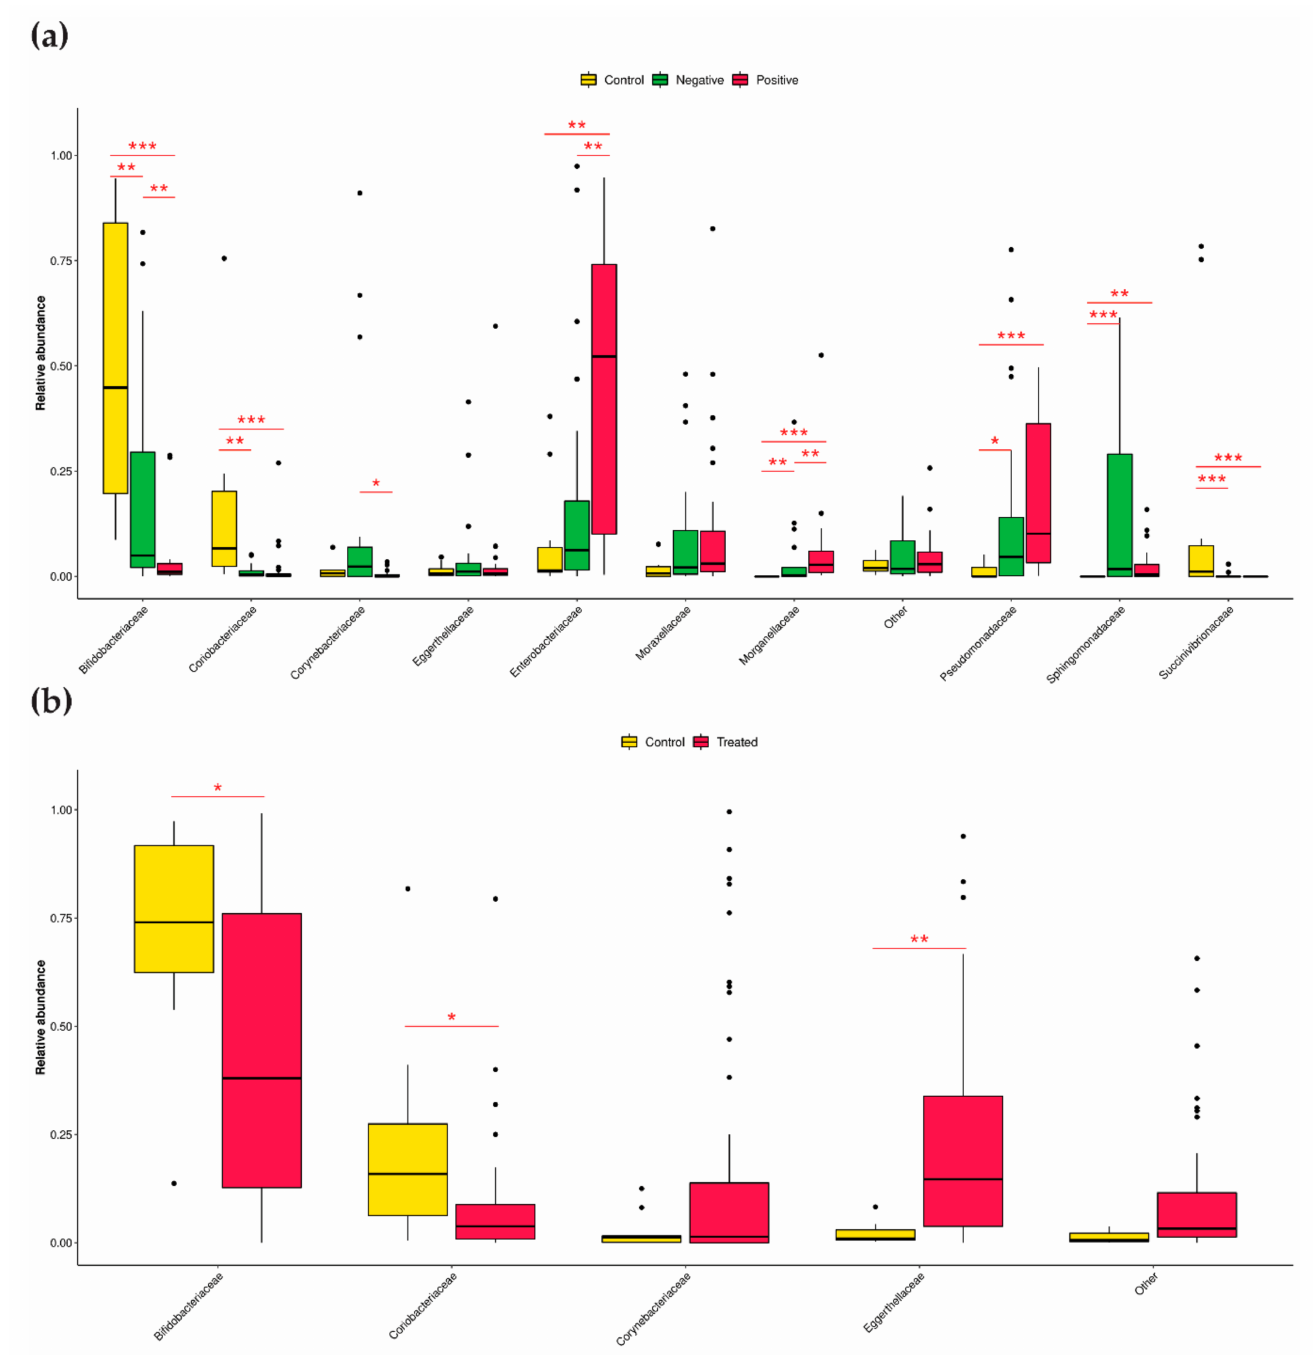
Figure 4. Relative abundance of families in the CRE-based and antibiotic regimen-based groups. ( a ) Relative abundance of the top families in the CRE-based groups. ( b ) Relative abundance of the top families in antibiotic regimen-based groups. All taxa with a gene copy number-corrected relative abundance below the respective 3rd quartile were classified as “Other”. Differences in the relative abundance of the CRE-based groups were identified using Kruskal–Wallis followed by Dunn’s post hoc test. Differences between the antibiotic groups were identified using the Wilcoxon test. An adjusted or nominal p value threshold of 0.05 was used to define statistical significance. * (adjusted) p -value < 0.05; ** (adjusted) p -value < 0.01; *** (adjusted) p -value <